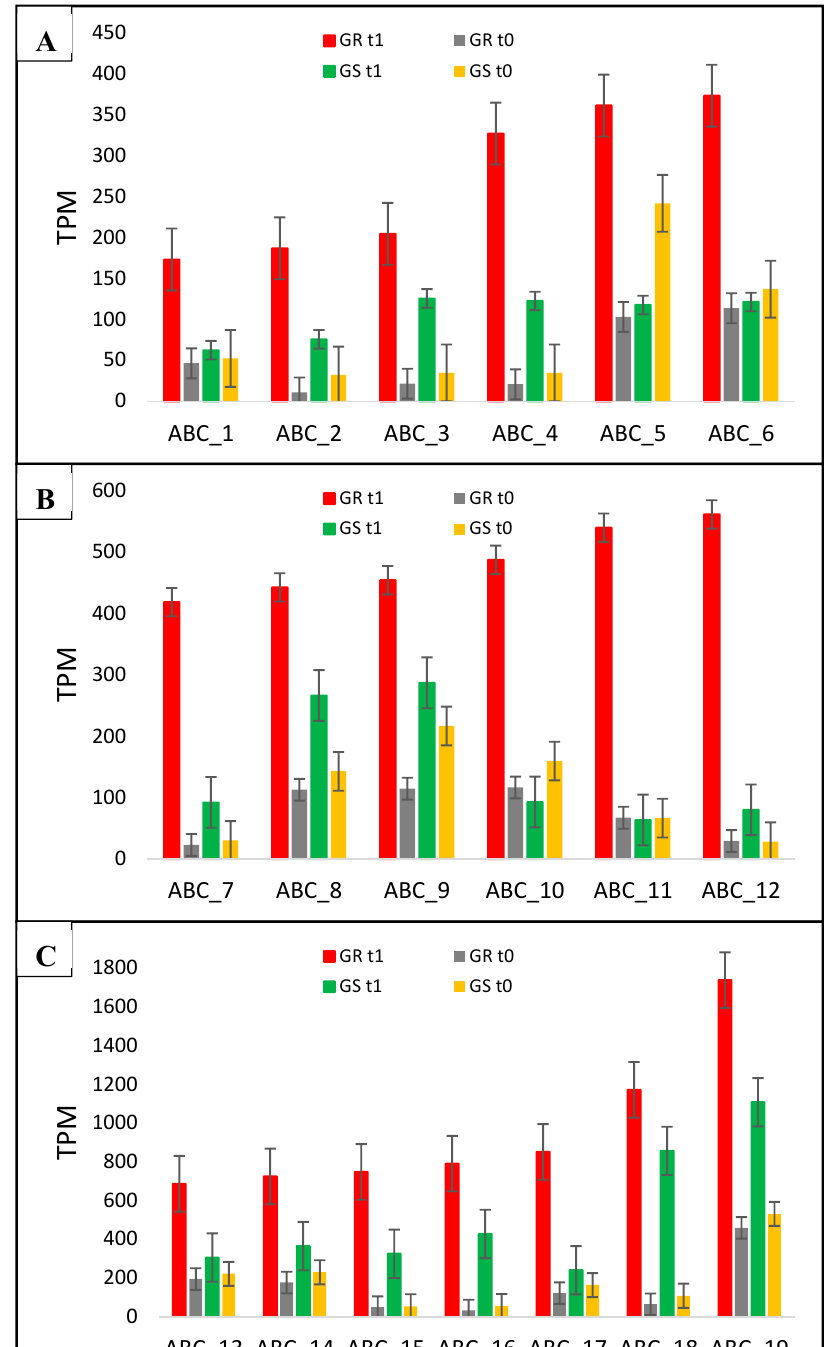
Figure 5. C. bonariensis transcriptome expression analysis (transcript reads per million mapped reads—TPM) of the 19 ABC transporters genes (1 to 19). GR: glyphosate-resistant biotype; GS: glyphosate-sensitive biotype. t0: without glyphosate treatment; t1: with glyphosate treatment—RNA was obtained from plants collected at several timepoints up to 288 h after treatment and pooled. Intervals indicate the standard error. In ABC_12 (ABC transporter C family member 14) and ABC_14 (ABC transporter C family member 9), the qRT-PCR analysis was performed (see Figure 4). The phylogenetic tree of these genes is presented in Figure S10.